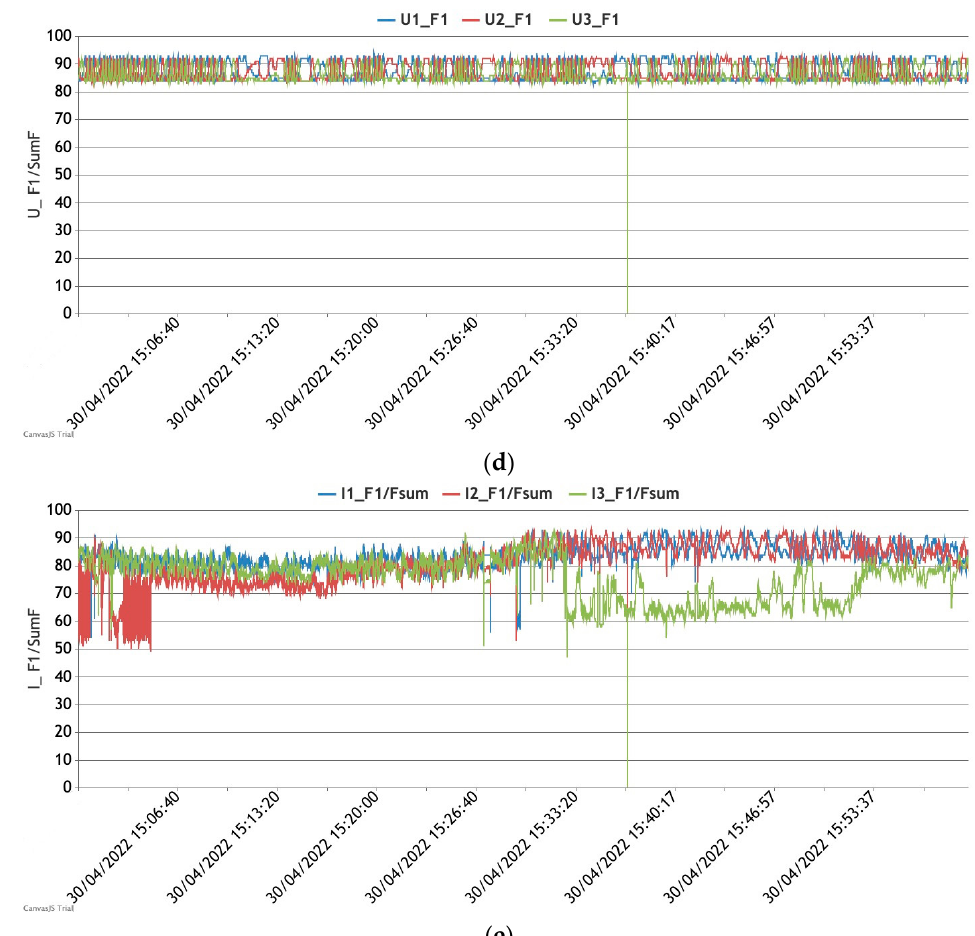
Figure 6. ( a ) Registered voltages and currents; ( b ) calculated THD for phases U1, U2, and U3; ( c ) calculated 1st harmonic value against the sum of all harmonic values for phases U1, U2, U3; ( d ) calculated THD for phases I1, I2, and I3; ( e ) calculated 1st harmonic value against the sum of all harmonics values for phases I1, I2, and I3; (see also https://remotelab.lv/power/powerD2_THD.php (accessed on 1 March 2023); please note that the webpage is slow to load).